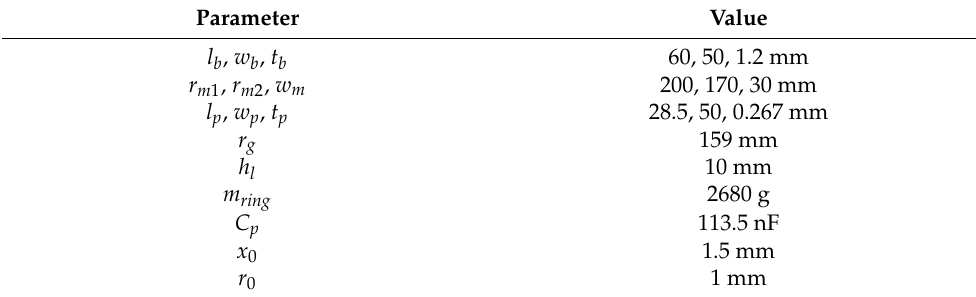
Figure 7. Prototyped rotational piezoelectric energy harvester mounted on a wheel hub. Table 1. Parameters of the beam structure and piezoelectric